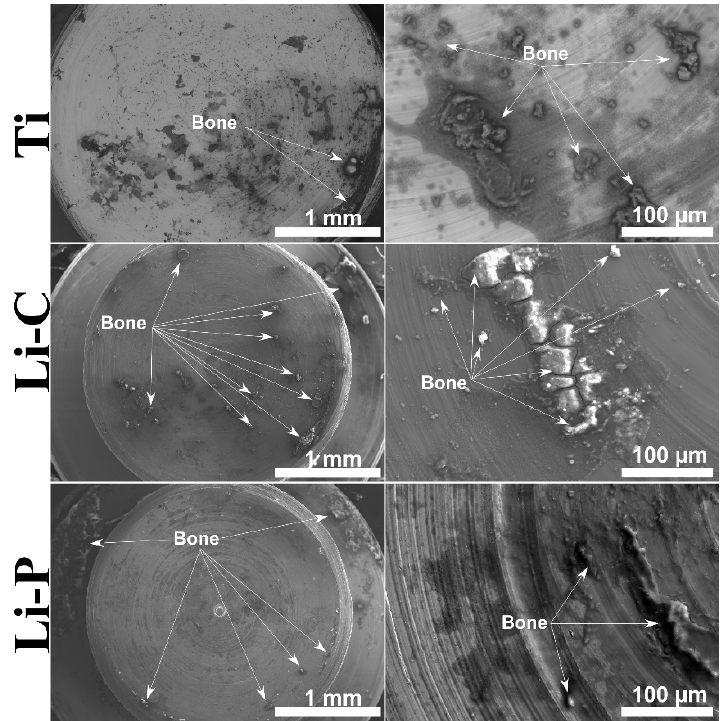
Figure 9. SEM micrographs indicating bone detachment on the surface of a control and functionalized (with Li-C and Li-P coatings) Ti implant, at 4 weeks after surgery.